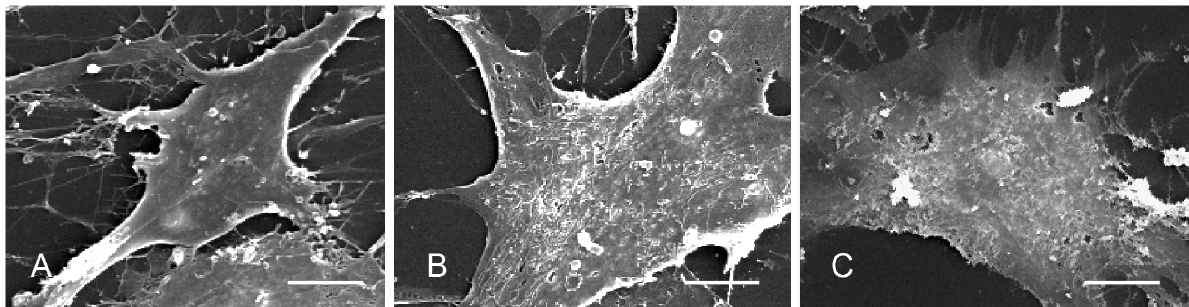
Figure 2. Ultrastructure analysis of HP-PRRSV-infected PPMVECs by scanning electron microscopy. (Bar = 4 µm). ( A ) Normal control group. ( B ) HP-PRRSV HN-infected group. ( C ) HP-PRRSV JXA1-infected group.